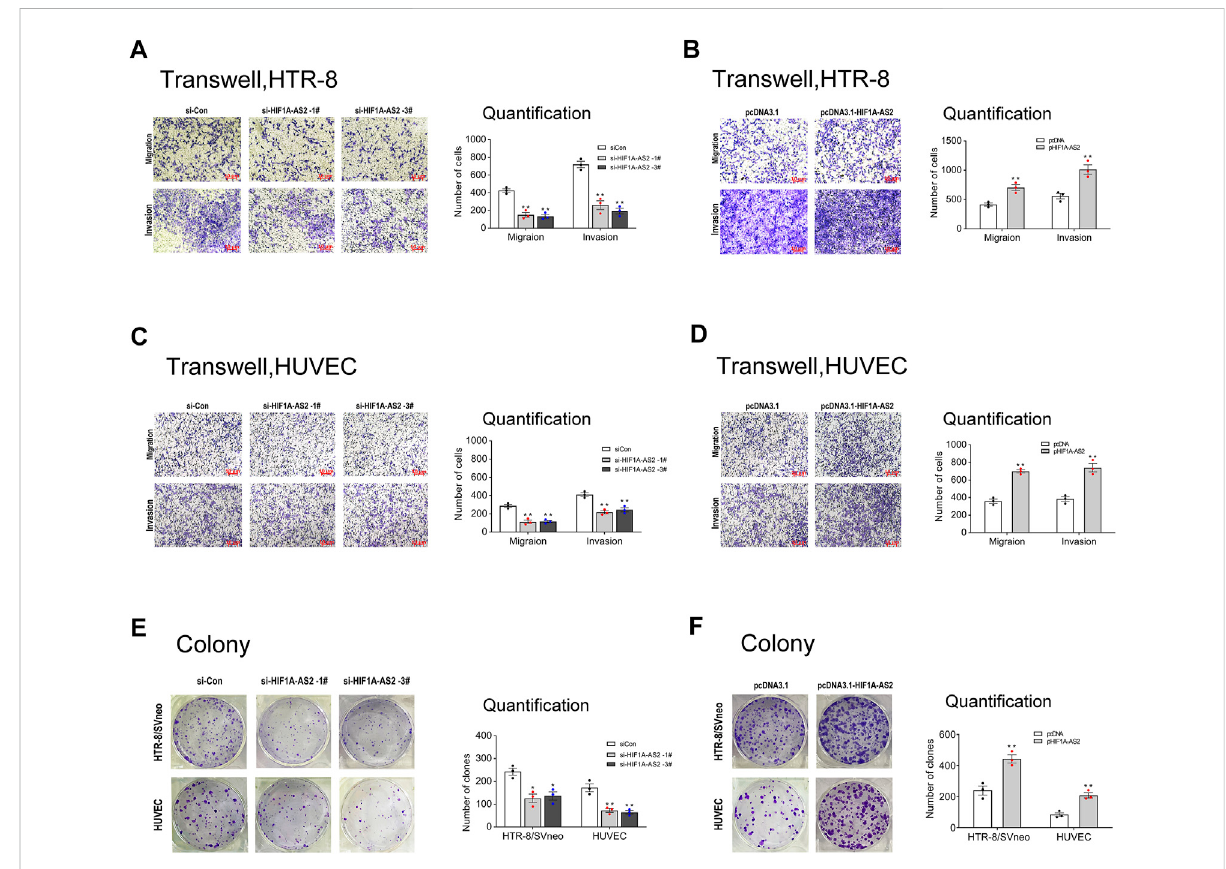
FIGURE 2 HIF1A-AS2 promotes trophoblast proliferation, migration and invasion in vitro . Transwell assays showed the migratory and invasive abilities of si HIF1A-AS2 -treated in HTR-8/SVneo (A) and HUVECs (C). The quantity of cells was markedly decreased compared to siCon control. With the treatment of overexpressed HIF1A-AS2, the 2 cell lines showed signi fi cant increase than that in pcDNA control (B,D) . Colony formation assay to assess theability ofproliferationinHTR-8/SVneo and HUVEC cells, transfected with siRNAs orplasmid.Silenced HIF1A-AS2 expression in HTR- 8/SVneo and HUVEC cells (E) and overexpressed- HIF1A-AS2 (F) . The statistics of the relevant data is on the right side of the corresponding graph. Error bars are mean with SEM of technical replicates ( n = 3), * p < 0.05, ** p < 0.01; signi fi cance by Student ’ s t